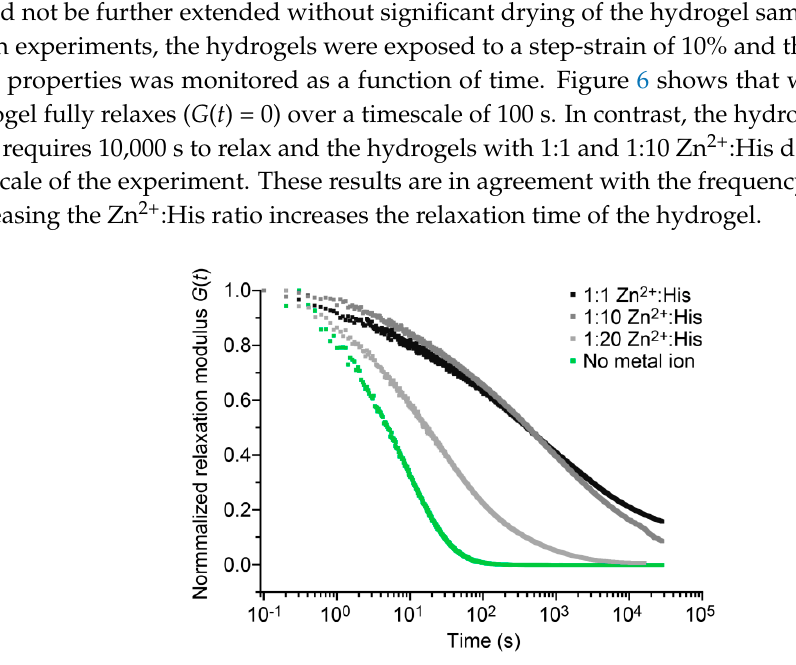
Figure 6. Stress relaxation of A 4H3 B 4H3 -containing hydrogels without metal ions and with different Zn 2+ :His ratios (1:1, 1:10, and 1:20). The stress relaxation of the hydrogels was monitored after applying a step-strain of